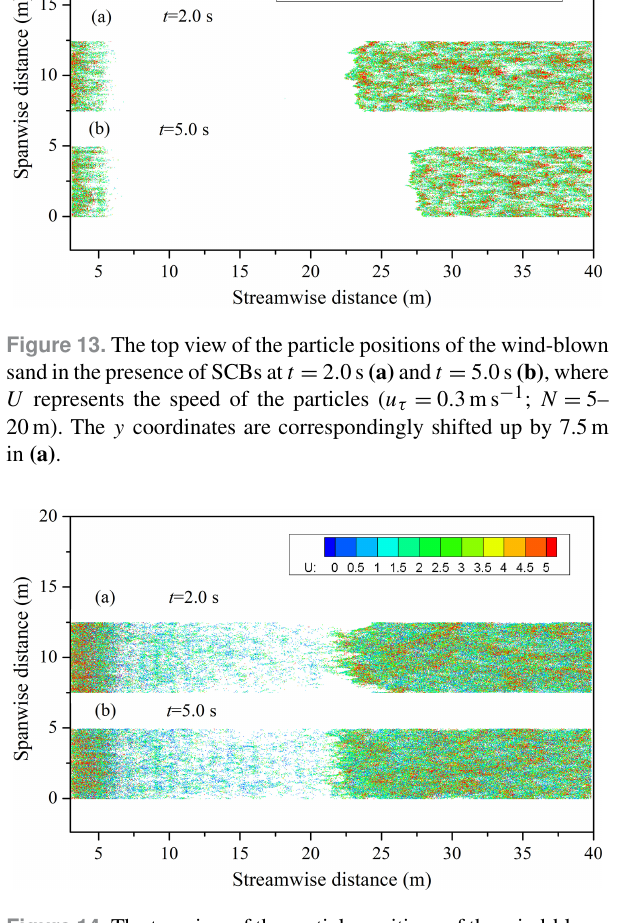
Figure 14. The top view of the particle positions of the wind-blown sand in the presence of SCBs at t = 2 . 0s (a) and t = 5 . 0s (b) , where U represents the speed of the particles ( u τ = 0 . 6ms − 1 ; N = 5– 20m). The y coordinates are correspondingly shifted up by 7.5m in (a)